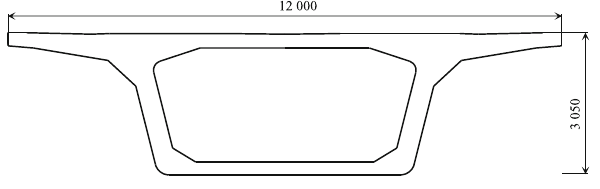
Fig. 7 Bridge cross-section